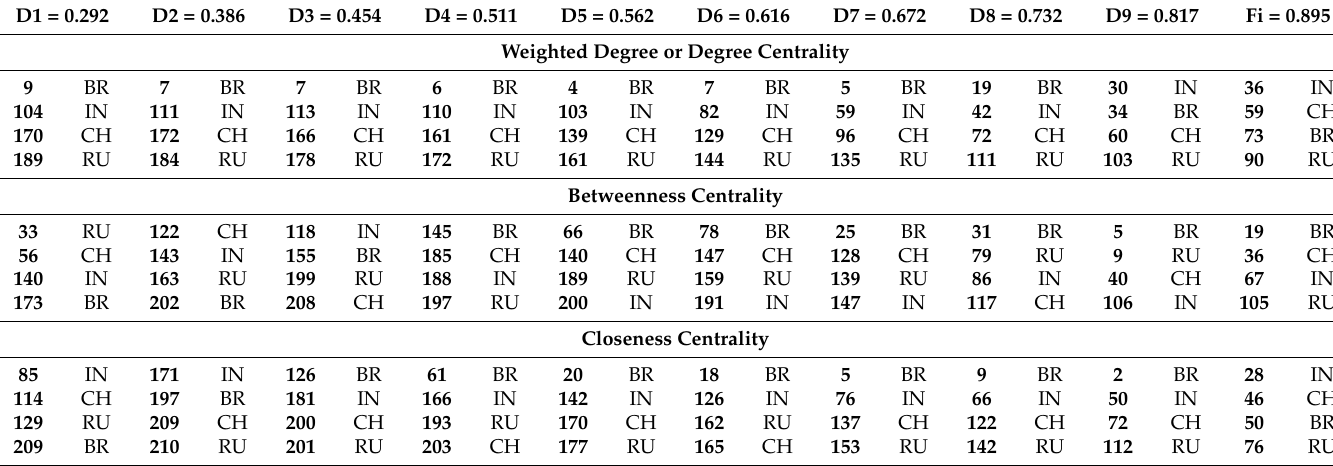
Table 4. Ranking of BRIC countries for centrality measures for ten different thresholds used to filter weak links. Nine filters correspond to deciles of the distribution of similarities. The last column (Fi) includes the filter used to create the network in Figure 2. See Appendix C for detailed